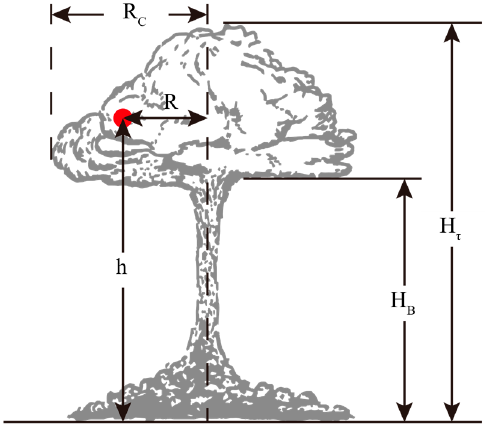
Figure 1. Geometry of the stable smoke cloud of a nuclear explosion.